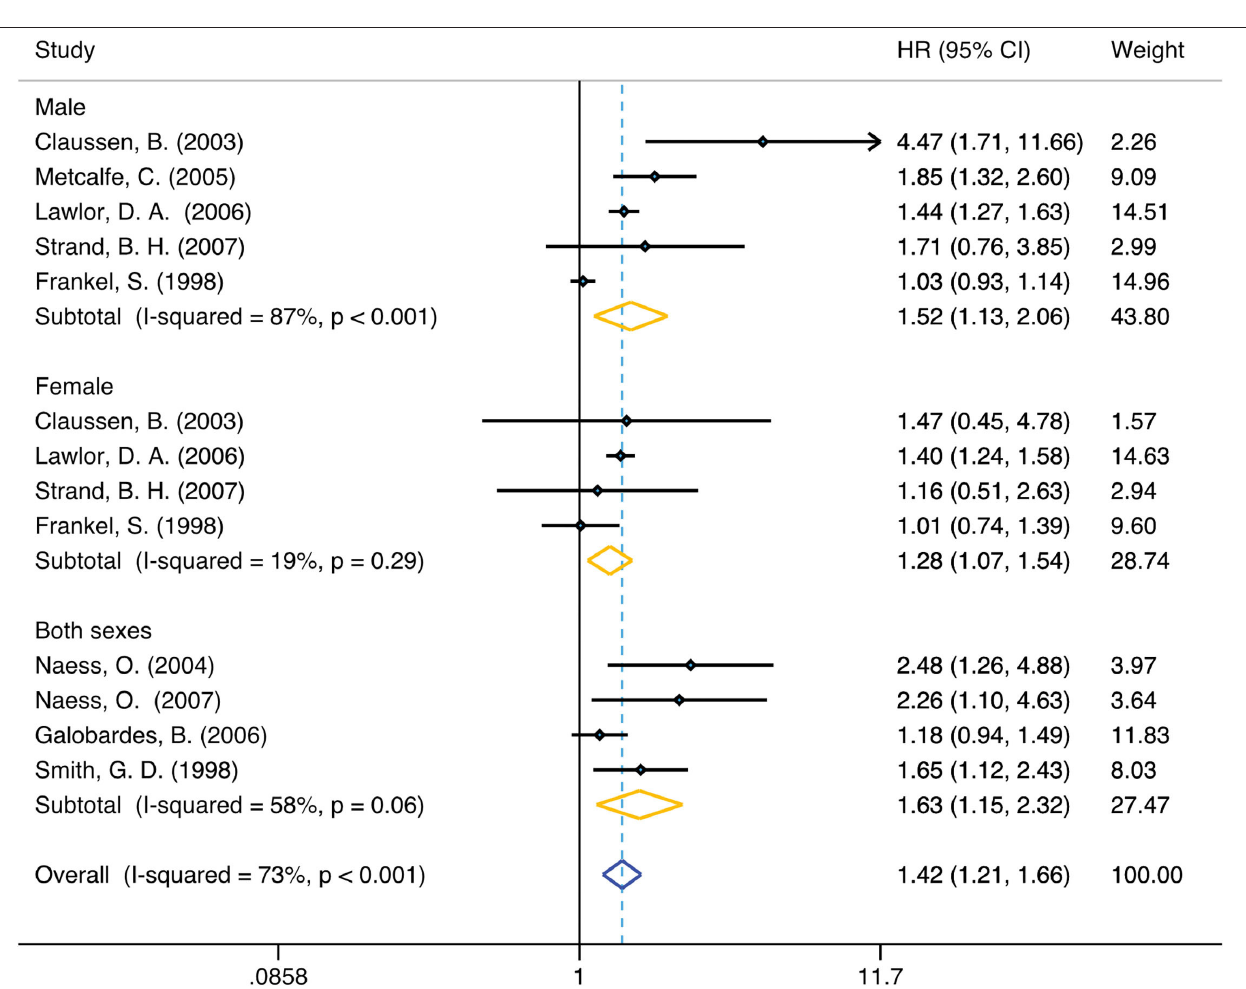
FIGURE 2 | Forest plot of population-based cohort studies of family SEP and lung cancer, stratified by sex (unadjusted